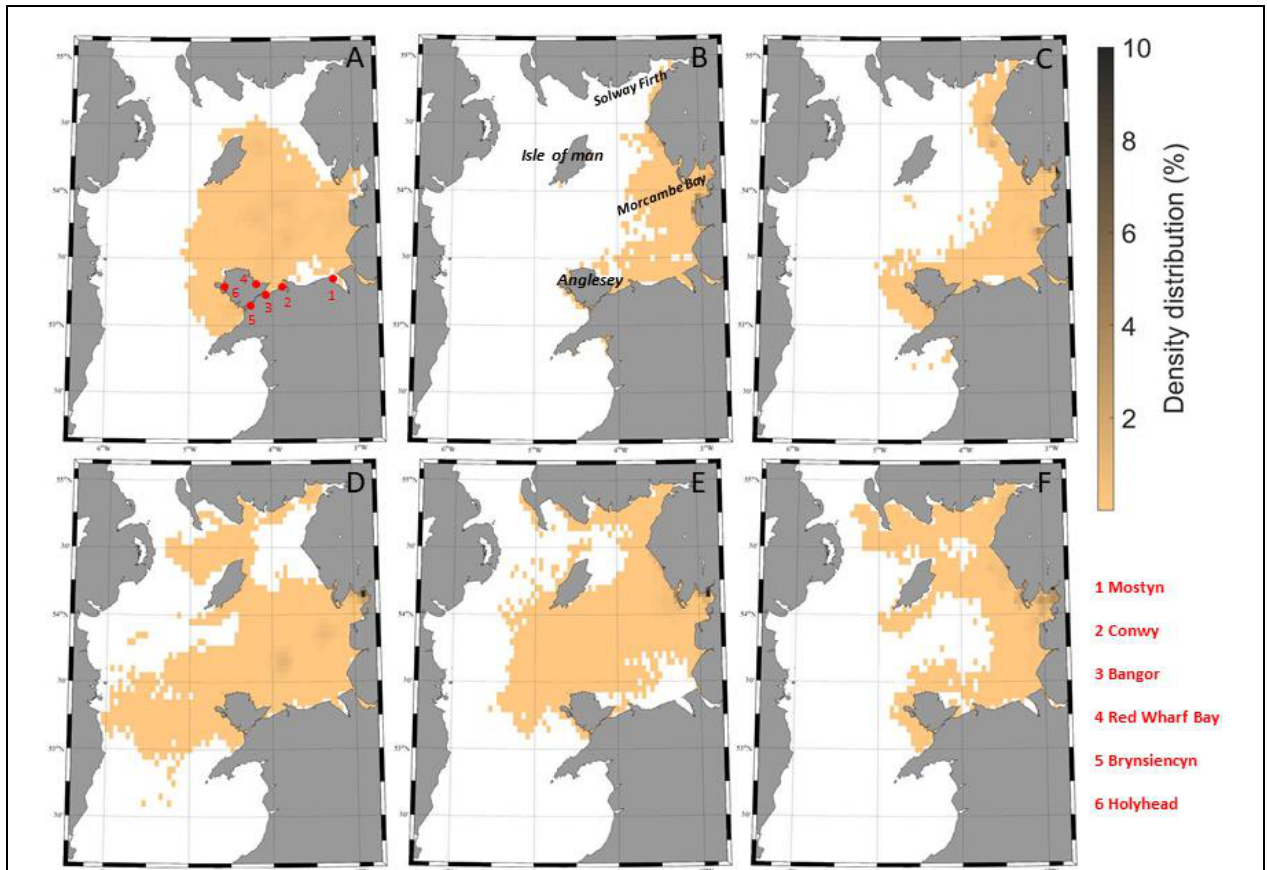
Fig. 4. Maps showing the density distribution of mussel larvae released at the surface in March-April 2014 from 6 released areas (red dots) during: (A) week 1; (B) week 2; (C) week 3; (D) week 4; (E) week 5 and (F) week